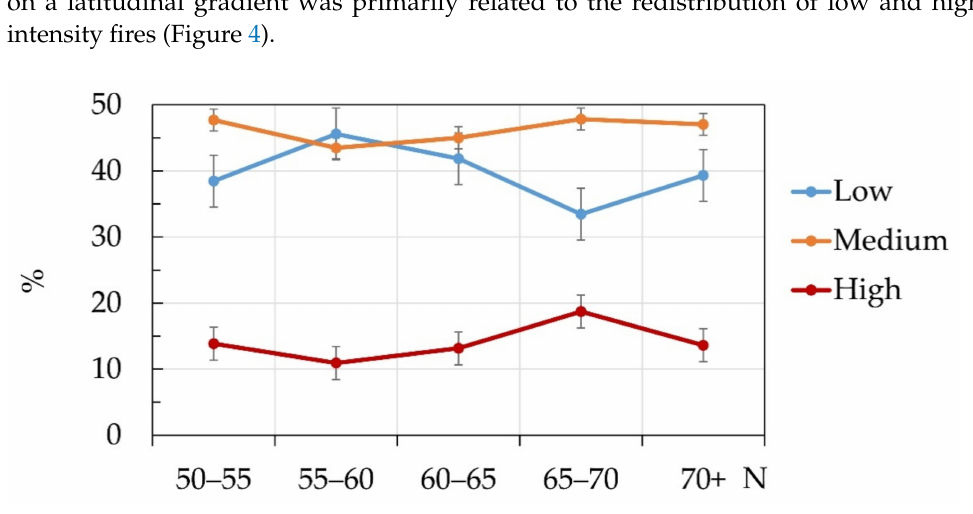
Figure 4. Ratio of fires of low, medium, and high intensities on a latitudinal gradient 50 ◦ –70 ◦ +